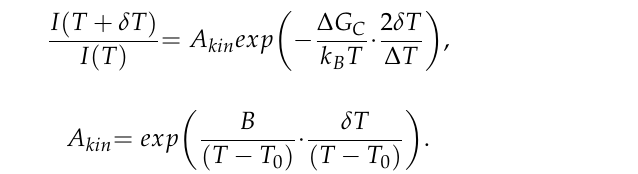
Table 2. Relative change in the nucleation rate due to a change in the kinetic barrier in silicate glasses at δ T = − 1 K.